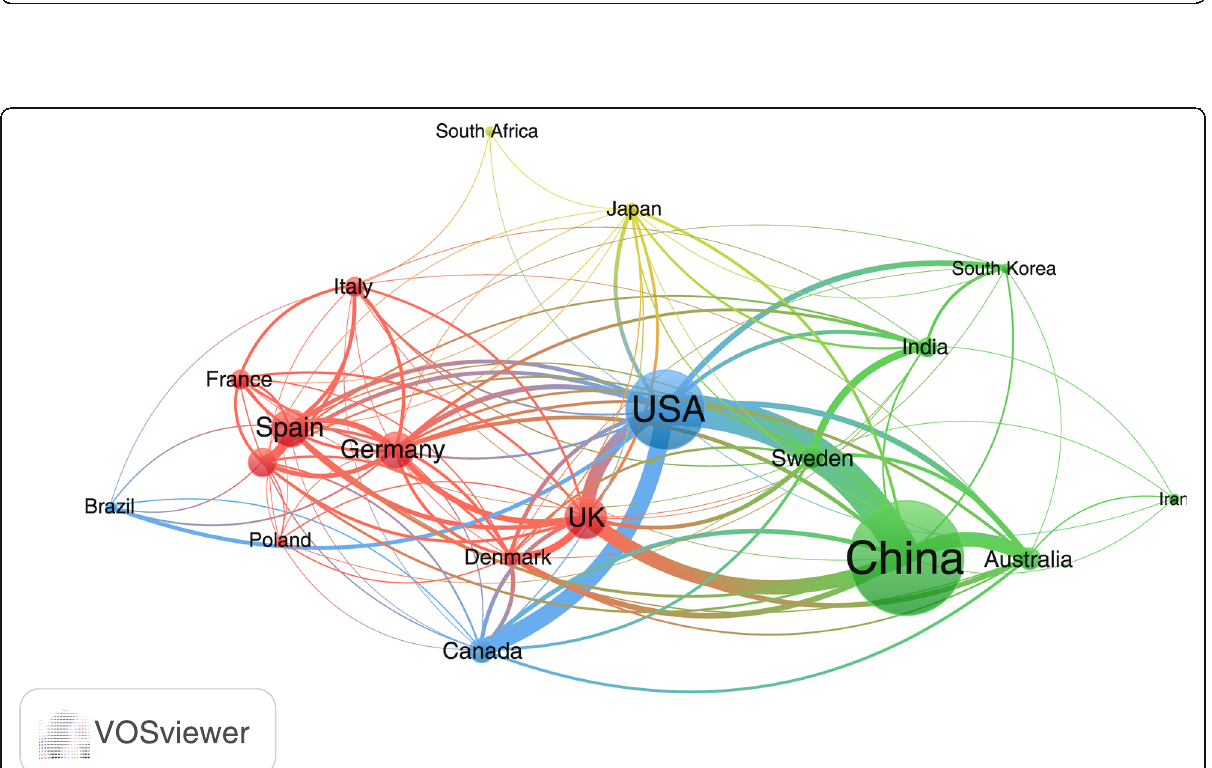
Fig. 4 Network visualization map of international research collaboration among countries with minimum research output of 50 documents on AMR in the environment. The thickness of the connecting lines represents the strength of research collaboration between any two countries. The connecting line between the USA and China represents the strongest research collaboration due to it thickness relative to other lines